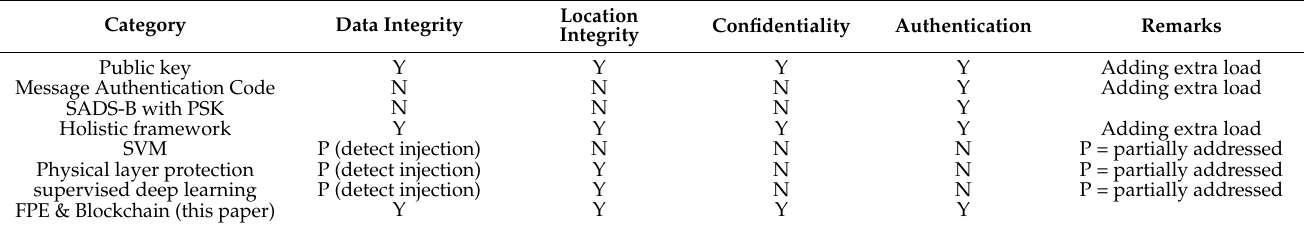
Table 4. Security requirement comparison of various